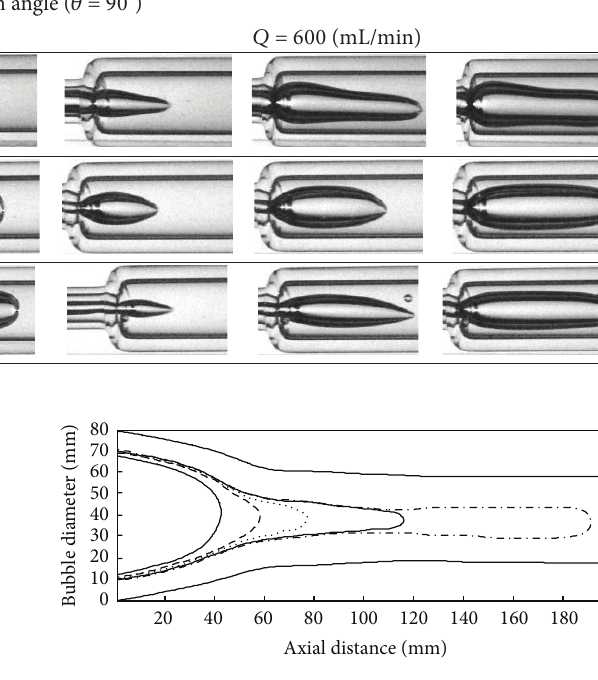
Figure 15: Bubble shape continuous variation in 1.5wt% PAA for sudden contraction angle 𝜃 = 15 ∘ and 200